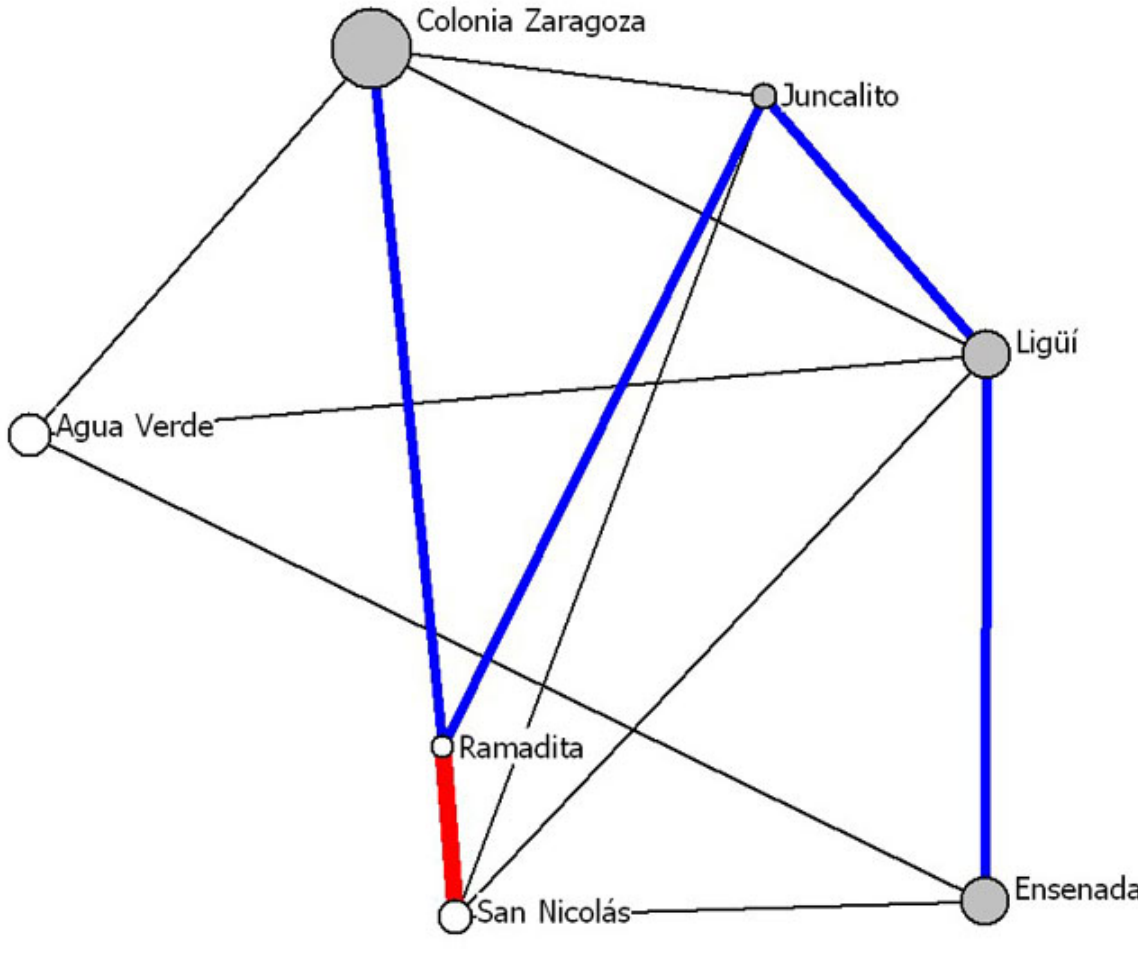
Fig. 7. Multi-dimensional scaling plot showing the friendship linking structure among the seven communities. The size of each node (community) is proportional to the number of fishers considered in each community; communities with high resource scarcity are shown with gray circles and communities with low resource scarcity are shown with white circles. The thickness of intercommunity links is proportional to the ratio of the measured vs. the expected number of relations. Thin line < 0.5 in black, medium line < 1 in blue, thick line > 1 in red. Ratio values less than 0.1 were